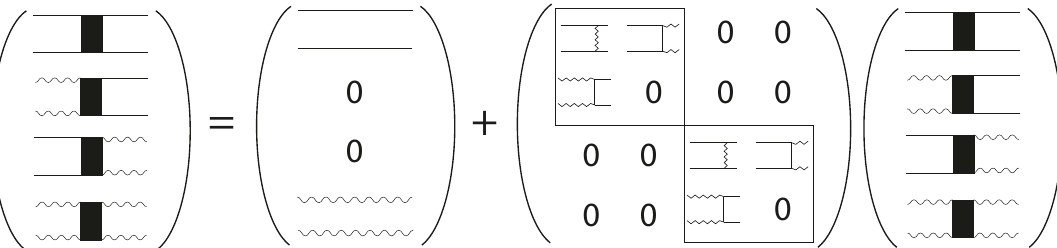
Figure 10. Here we show the matrix integral equation that the OTOCs obey. The black boxes indicate the arbitrary large amount of rungs in the ladder diagrams. The very left vector consists out of all the OTOCs, the (cid:12)rst vector on the right hand side denotes the zeroth order contributions to these and the last term is the kernel acting upon the vector of the four point functions. The matrix product also includes a convolution between the kernels and the OTOCs. Notice that the 4 (cid:2) 4 kernel matrix has a 2 (cid:2) 2 block diagonal